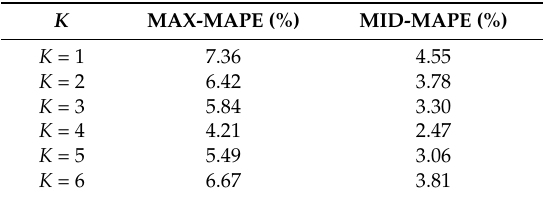
Table 3. The maximum and average MAPE of load forecasting under different clustering conditions in experiment B.